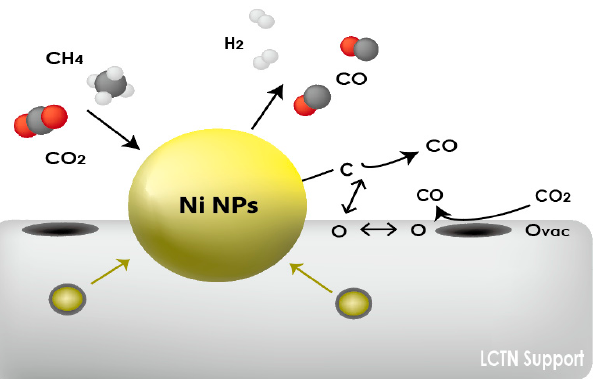
Figure 7. Schematic diagram of reaction mechanism of DRM reaction over eluted Ni NPs on the perovskite catalysts .